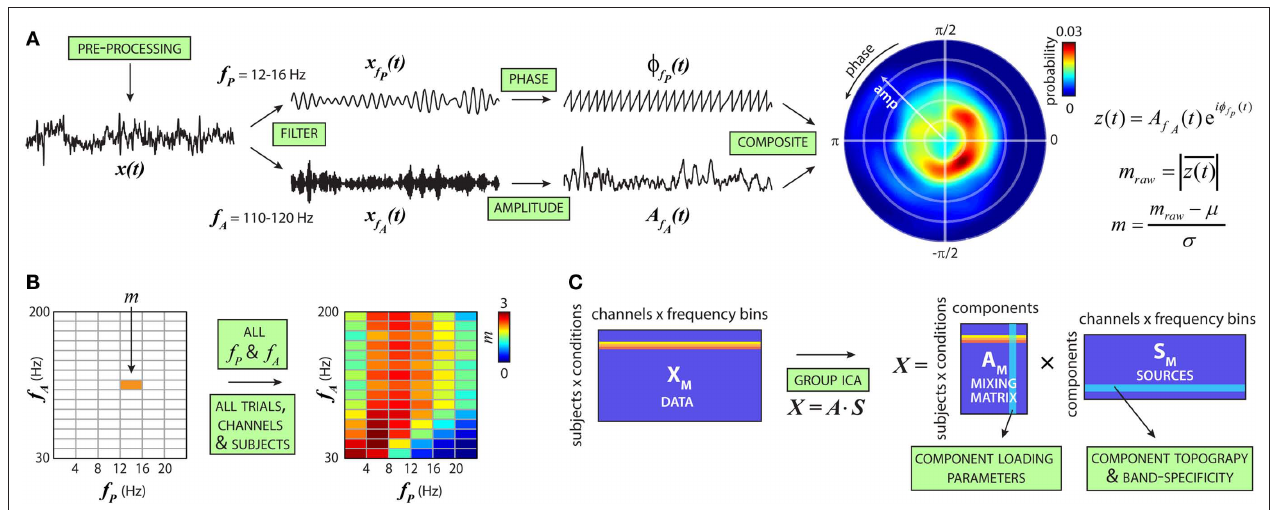
FiGuRE 1 | Schematic of cross-frequency modulation analysis. (A) Steps to compute the cfM index ( m ). AOD trials are pre-processed and filtered into low-frequency bands [e.g., f = 12–16 Hz, forming x ( t )] and high-frequency bands P fP [e.g., f = 110–120 Hz, forming x ( t )]. Analytic phase, φ ( t ), and amplitude envelope, A fA A ( t ), are extracted from x ( t ) and x ( t ), respectively, to form a composite signal: fP fA z ( t ) = A ( t ) e i φ ( t ) . Coupling between low-frequency phase and high-frequency amplitude is present if the probability distribution of z ( t ) is circularly non-uniform, equivalently, if the length of z ( t ),